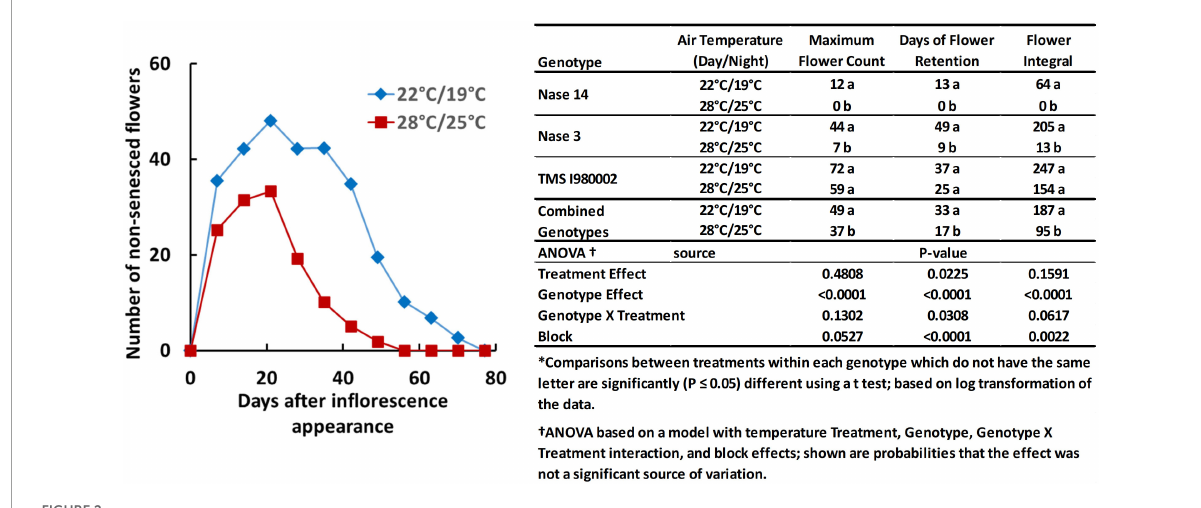
FIGURE2 Floral development in genotypes Nase 14, Nase 3, and TMSI980002 at tier 2, grown at day/night temperatures of 22/19 and 28/25 ◦ C. Graph represents weekly mean flower counts averaged across all three genotypes.